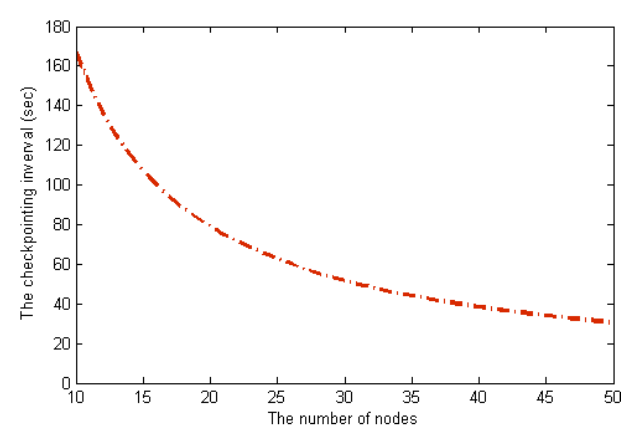
Figure 11. The checkpointing interval.